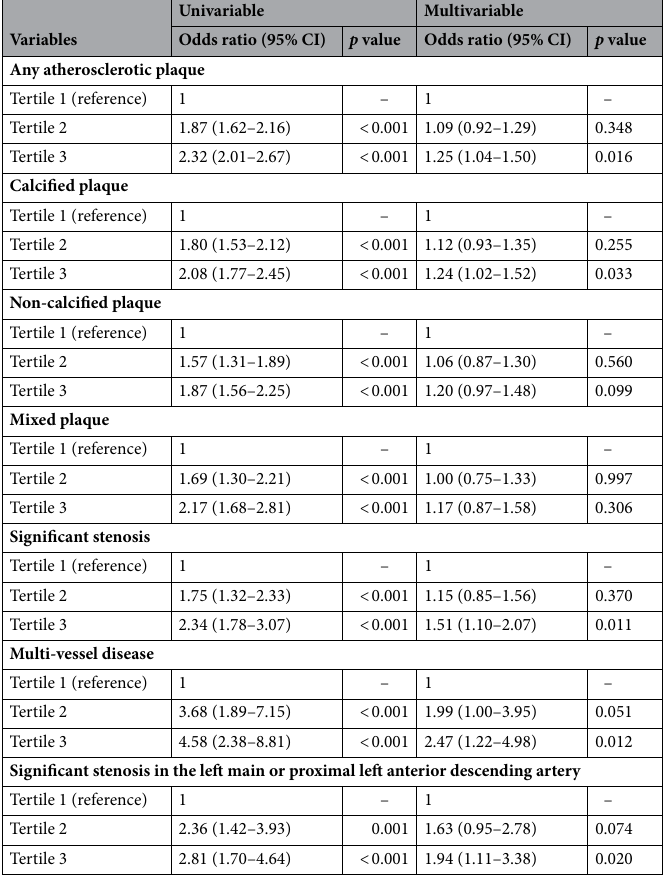
Table 3. Association between gamma-glutamyl transferase levels and coronary computed tomography angiographic findings. CI confidence interval. Covariates in the multivariable model include age, sex, obesity, diabetes mellitus, hypertension, hyperlipidemia, creatinine, uric acid, current smoking, family history of coronary artery disease, and high-sensitivity C-reactive protein ≥ 2